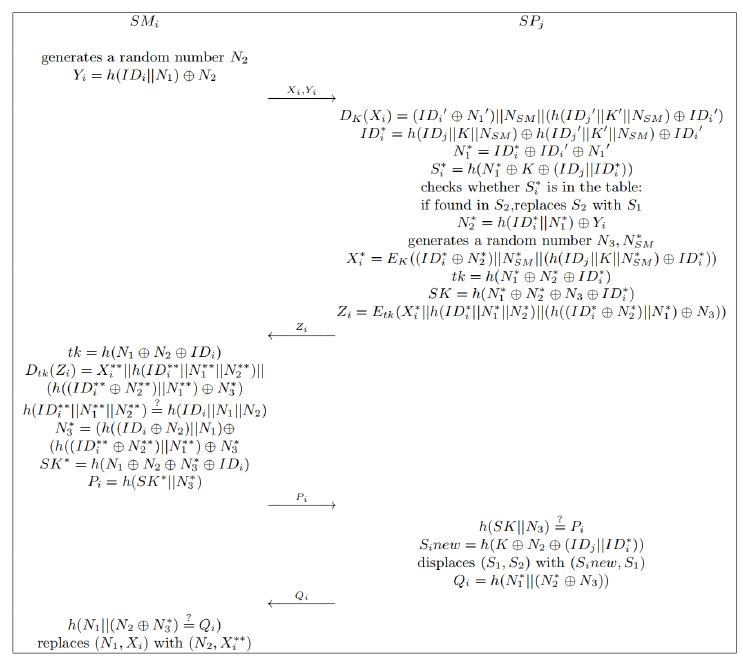
Figure 7. Authentication and key agreement